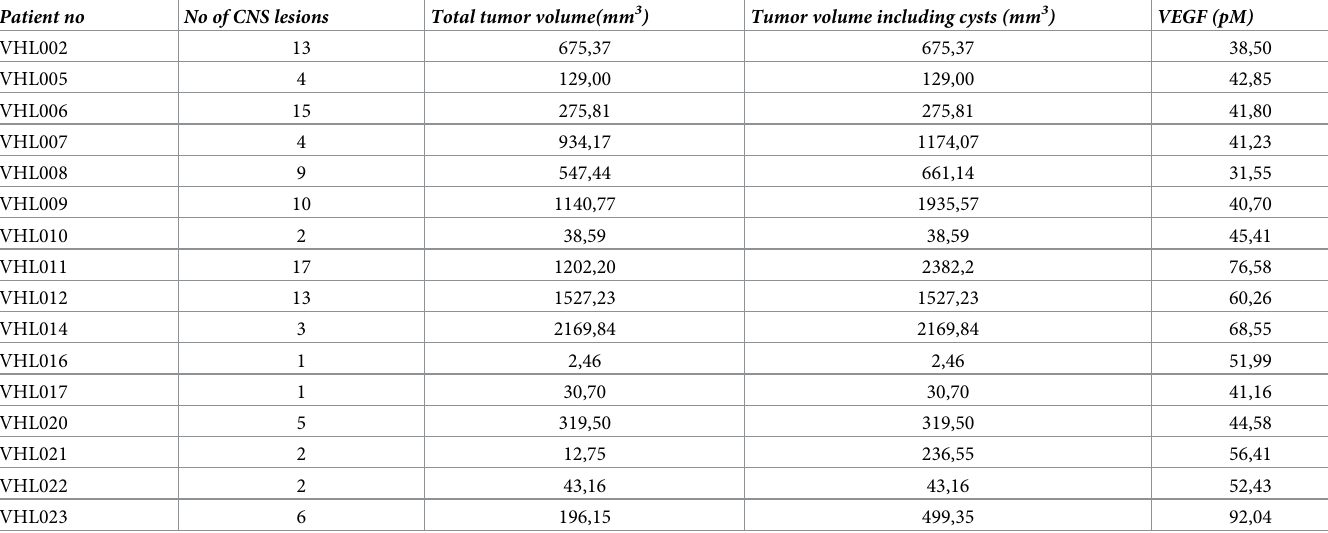
Table 2. VEGF levels at initial visit in patients with CNS